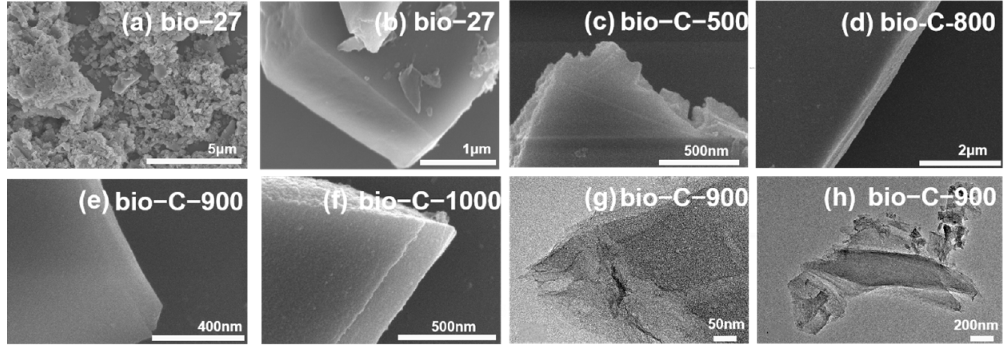
Figure 3. ( a – f ) SEM images of bio − 27 and bio − C − T. ( g , h ) HRTEM of bio − C − 900.